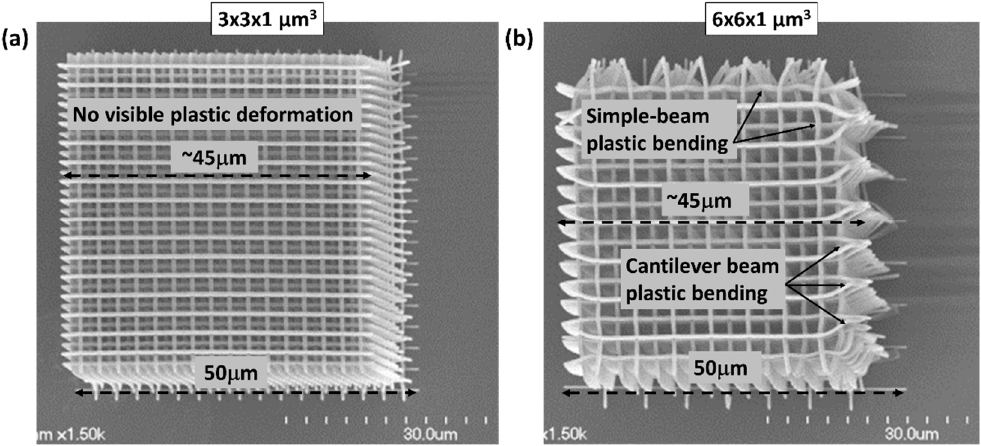
Figure 3. Log-pile structures with ( a ) 3 × 3 × 1 μ m 3 and ( b ) 6 × 6 × 1 μ m 3 cell size fabricated in IP-Dip resin with ~300–400 nm line width. Note the lack of observable plastic deformation at the smaller cell size in ( a ) in contrast to the visible bending in the simply-supported and cantilever beam sub-elements at the larger cell size in ( b ).